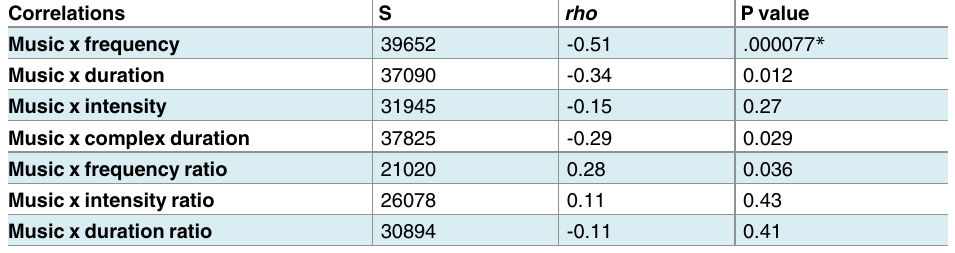
Table 6. Correlations between Gold-MSI generalized musical sophistication score and perceptual effects. Correlations S rho